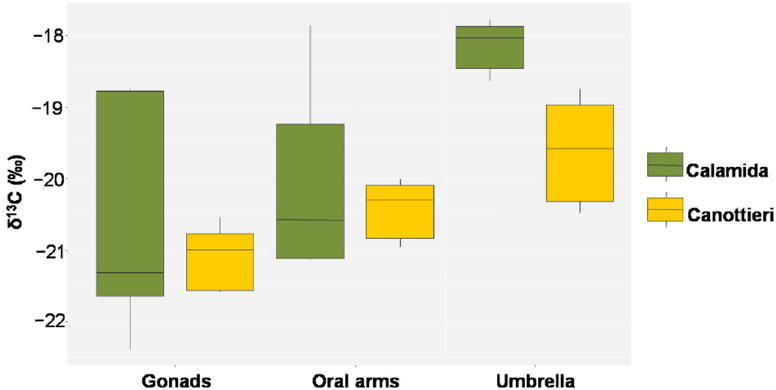
collected at the two sites of Cala ( N = 5 in Calamida and 5 in Canottieri).